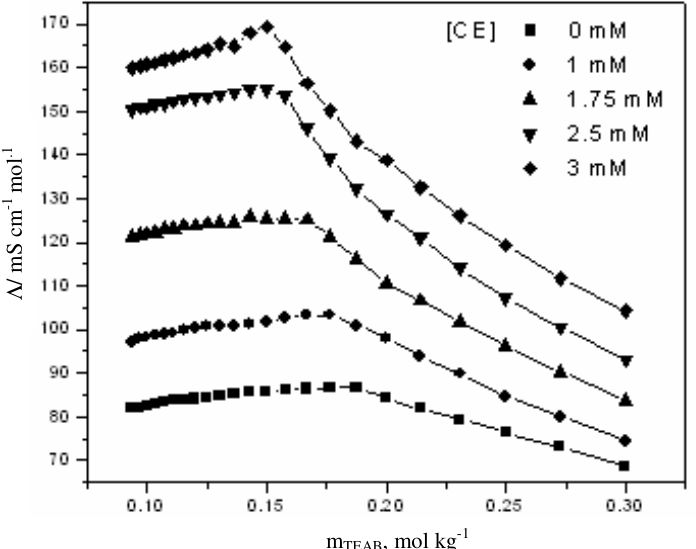
Figure 2. Molar conductivity plots for TEAB/CE/W ternary systems at 298.15K for different concentrations of crown